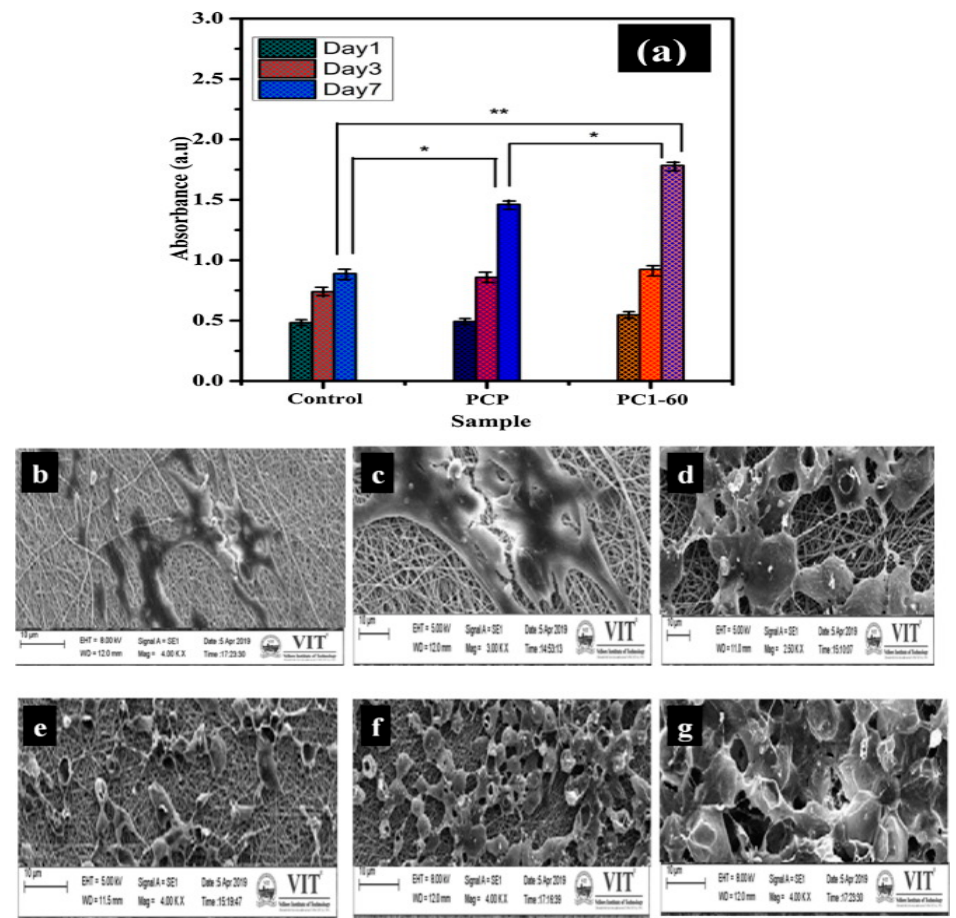
Figure 7 . MTT assay results for HOS cells seeded on CA/PVP (PCP) and CA/PVP/HA 0.1M Zn–Mg (PC1-60) membranes on the 1st, 3rd, and 7th days ( a ); microscopy images showing cellular growth ( b – d ) and attachment ( e – g ) on PCP and PC1-60 membranes (reproduced with permission from Ref. [61]).